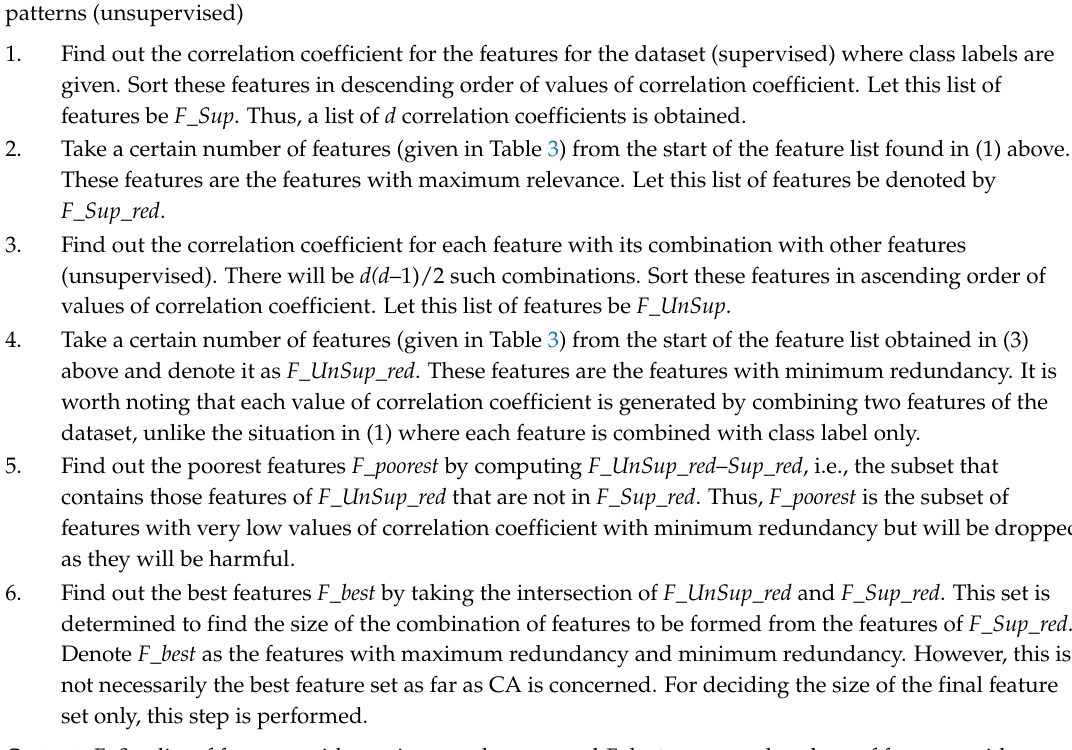
Algorithm 1 The maximum relevant and minimum redundant features